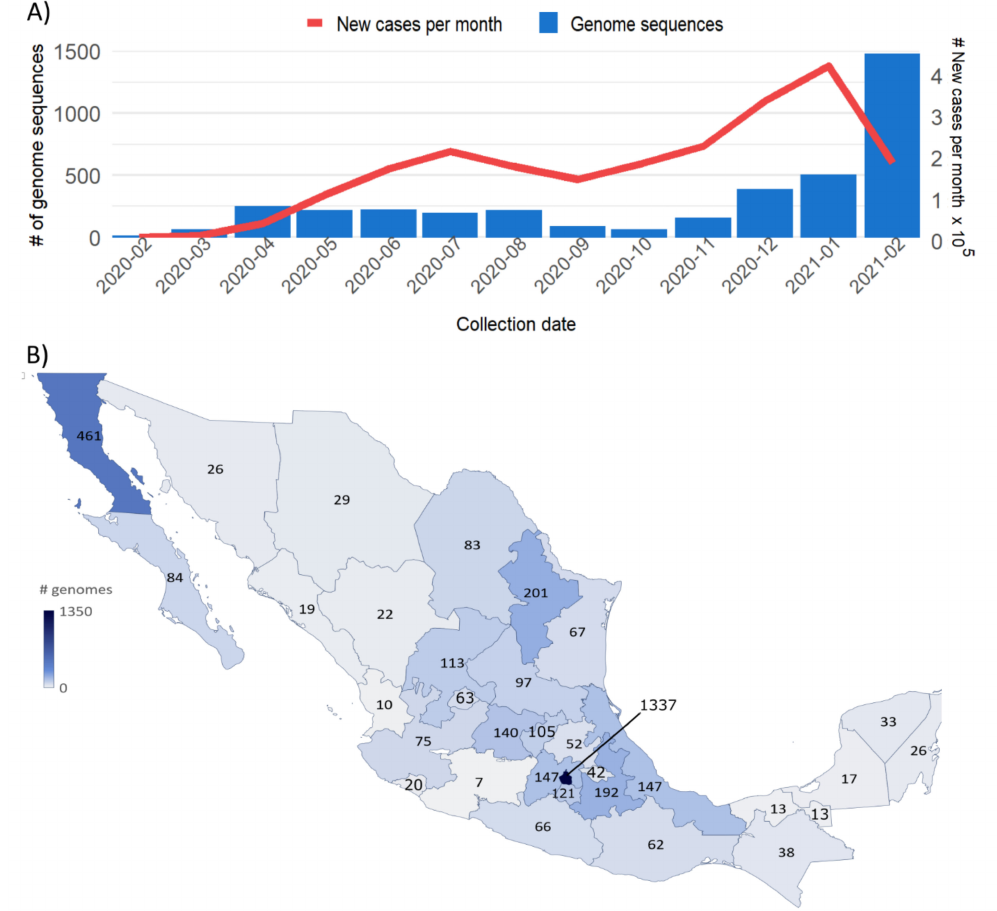
Figure 1. Geographical and monthly distribution of the 3915 Mexican SARS-CoV-2 genome sequences obtained from 27 February 2020 to 28 February 2021. ( A ) Number of national positive reported cases and SARS-CoV-2 genomes obtained per month. ( B ) Distribution of virus genomes by state. Adapted from [29] https://mapchart.net/mexico.html, accessed on 14 May